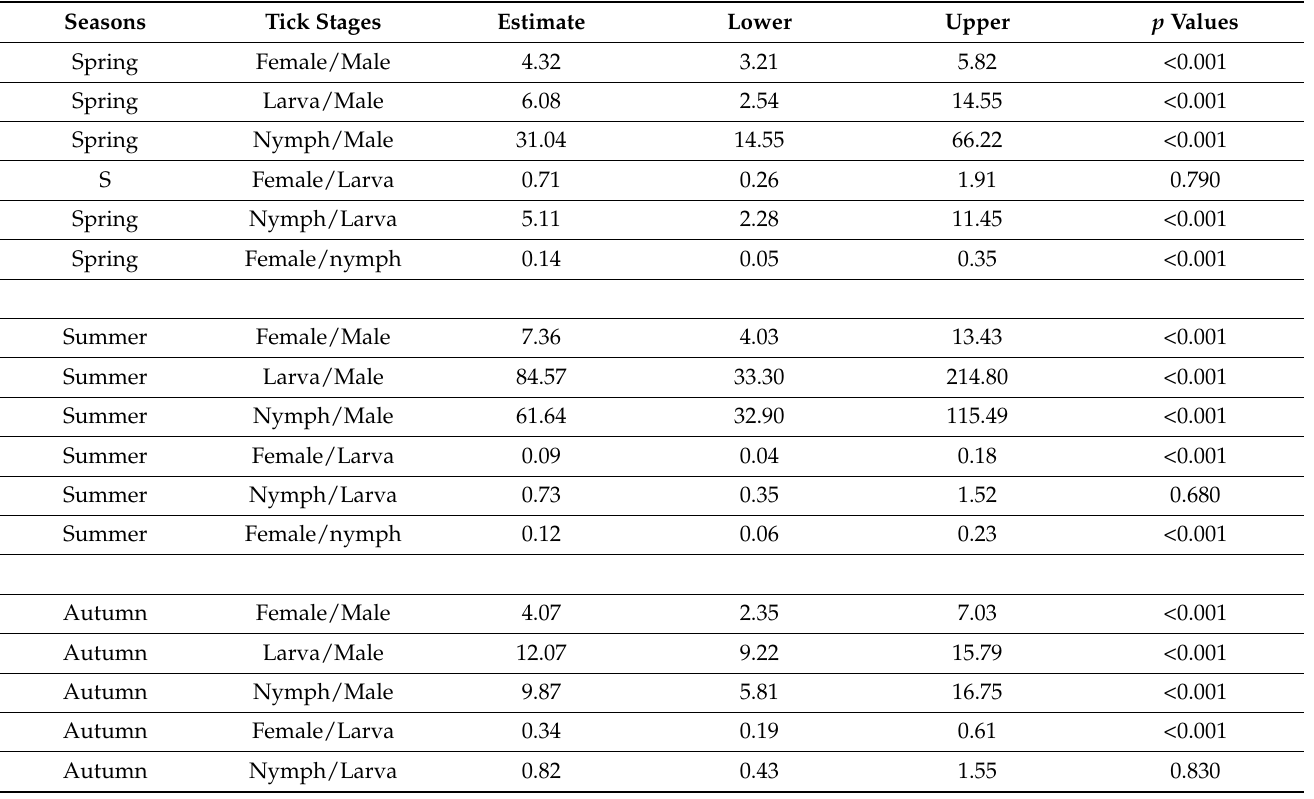
Table 3. Statistical comparison of seasonality of mean numbers of Ixodes ricinus per host between tick developmental stages. The applied statistical model was a marginal generalised linear model fitting Poisson